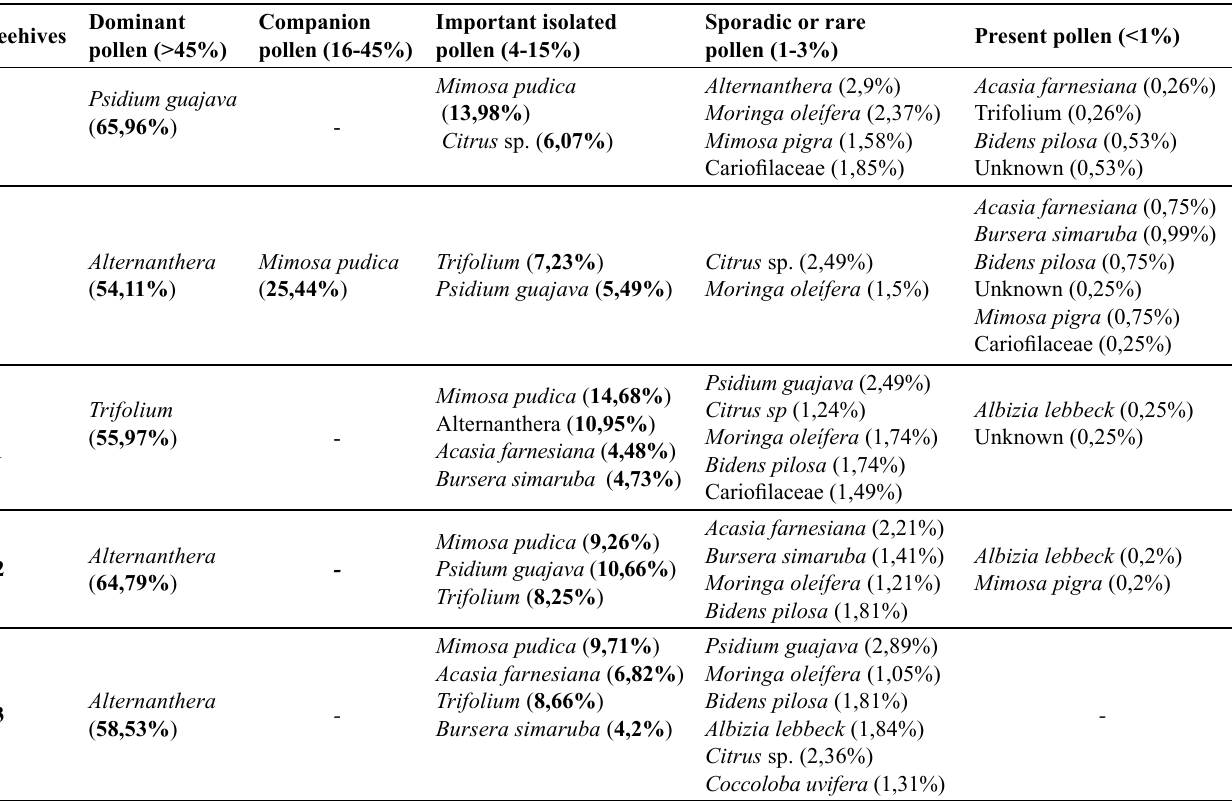
Table 3. Pollen types identified in the honeys from the beehives of Matanzas, Cuba, 2018.